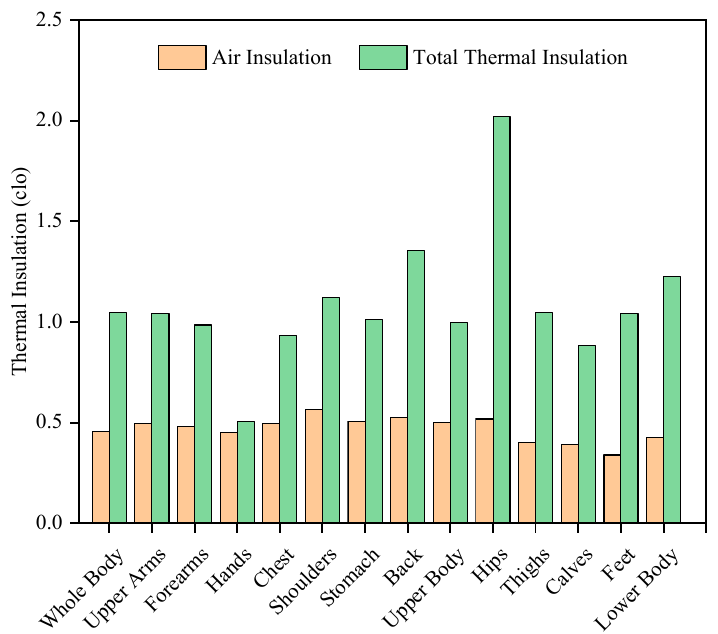
Figure 2. Total thermal insulation of power grid ensembles and air insulation at different body parts.